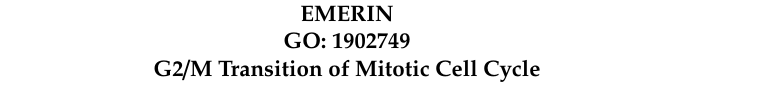
Table 1. High confidence interactors in enriched biological processes. Mass spectrometric data were analyzed using SAINT v. 2.5.0 [43,44] based on an average probability of ≥ 0.45. Gene ontology (GO) enrichment analysis for each LEM protein was done by using ENRICHR considering a fold change ≥ 1 and p -value ≤ 0.05 [47,49]. AvgP: Average